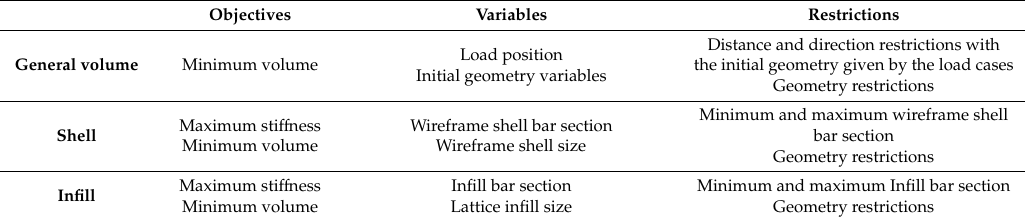
Table 2. Multi-objective optimization parameters applied to the beam example.